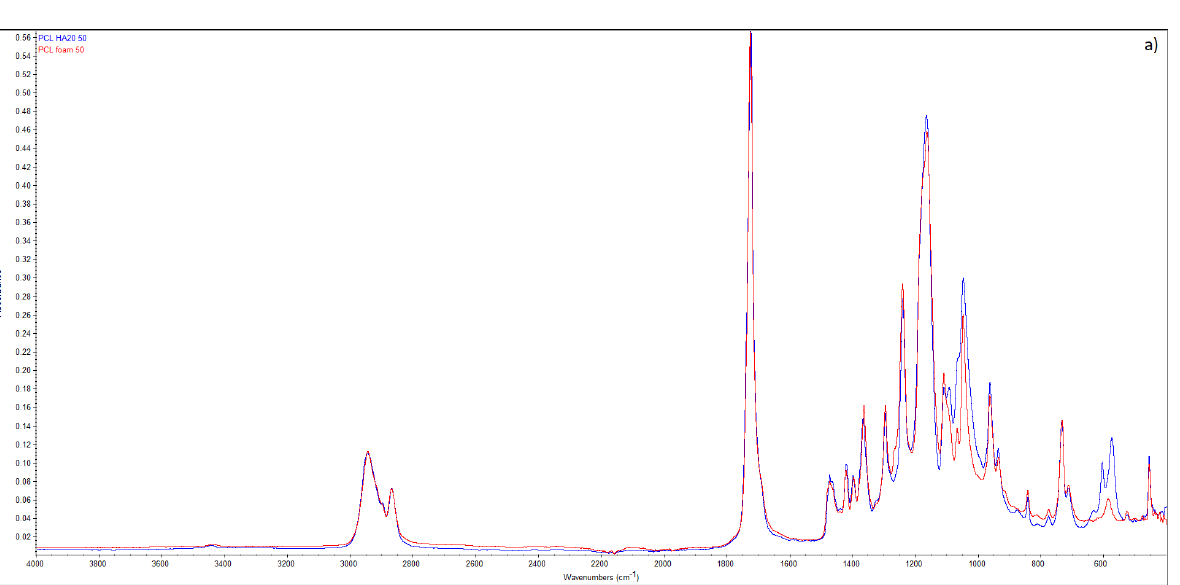
Figure 8. Fourier-transform infrared (FTIR) spectra of the PCL-HA 10 − 50 (red) and impregnated with carvacrol PCL-HA 10 − 50 scaffold (blue): ( a ) full spectra; ( b ) part of the spectrum with characteristic carvacrol’s peaks . FTIR analysis was also used to confirm the presence of HA in the composite foams. Spectra of the neat PCL scaffold and scaffold with 20% HA PCL-HA 20 -50 are presented in Figure 9. New intensive bands appearing in the spectrum of the composite scaffold at 570 and 600 cm − 1 , and at 1000 – 1100 cm − 1 originate from PO 43 − group [57].